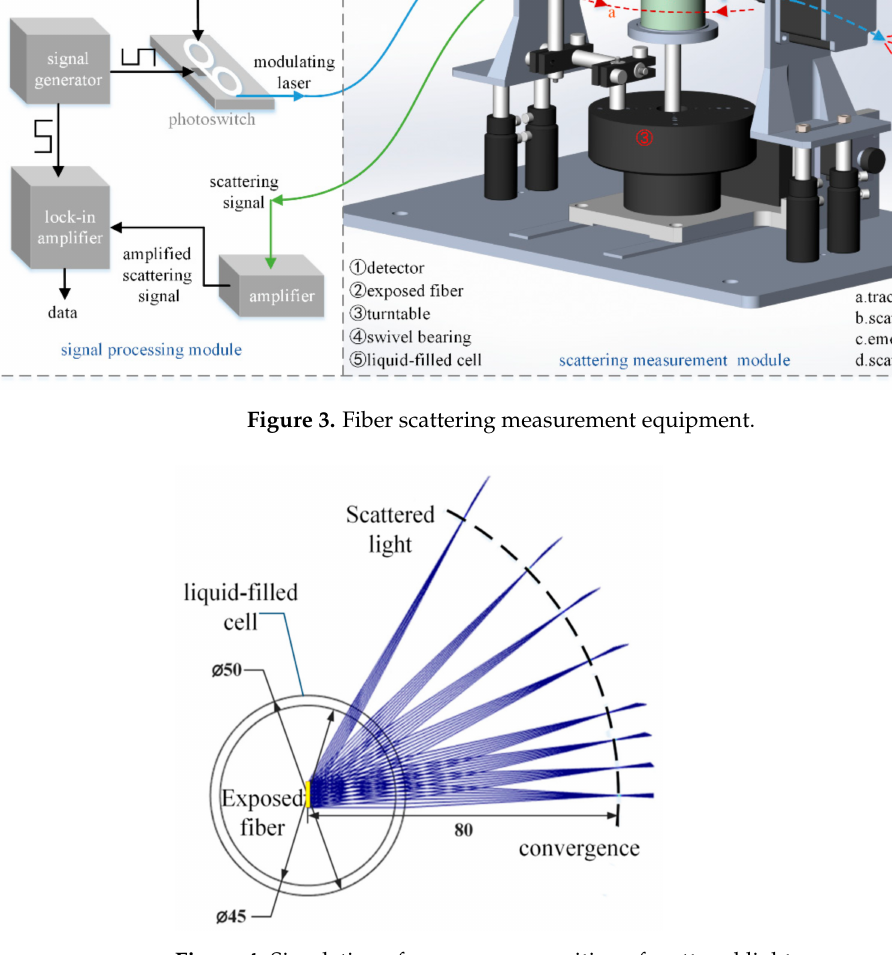
Figure 4. Simulation of convergence position of scattered